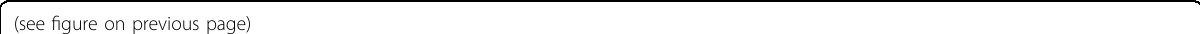
Fig. 2 LYPLAL1-AS1 depletion inhibits adipogenic differentiation of hAMSCs, whereas its overexpression promotes this process. a LYPLAL1-AS1 was silenced in hAMSCs using two independent siRNAs (siRNA-1 and siRNA-2). The knockdown ef fi ciency was veri fi ed by qRT-PCR as compared with the negative control (si-NC). b . qRT-PCR analysis of adipogenic markers (PPAR γ , AP2, LPL, and CEBP α ) in hAMSCs with LYPLAL1-AS1 knockdown and in control hAMSCs on day 3 after adipogenic induction. c Western blot analysis of adipogenic markers (PPAR γ , AP2, LPL, and CEBP α ) in LYPLAL1-AS1 knockdown hAMSCs or control hAMSCs on days 3 and 6 after adipogenic induction. d , e Oil red O staining of adipose lipids in hAMSCs treated with LYPLAL1-AS1 siRNAs and in control hAMSCs on day 10 after adipogenic induction ( d ) and quanti fi cation of the oil red O staining ( e ). f , g hAMSCs were transduced with lentivirus overexpressing LYPLAL1-AS1 (Lenti-LYPLAL1-AS1) or control lentivirus (Lenti-NC), and ectopic overexpression ef fi ciency was detected by fl uorescence observation ( f ) and qRT-PCR ( g ). h , i qRT-PCR ( h ) and western blot ( i ) analysis of adipogenic markers (PPAR γ , AP2, and LPL) in hAMSCs that overexpressed LYPLAL1-AS1 and in control hAMSCs on day 3 after adipogenic induction. j , k Oil red O staining of adipose lipids in hAMSCs that overexpressed LYPLAL1-AS1 and in control hAMSCs on day 10 after adipogenic induction ( j ) and quanti fi cation of the oil red O staining ( k ). GAPDH was used as internal controls for western blotting. The quantitative data were normalized to GAPDH, n = 3; data are shown as the mean ± SD; ** P < 0.01, *** P < 0.001; scale bars: 200